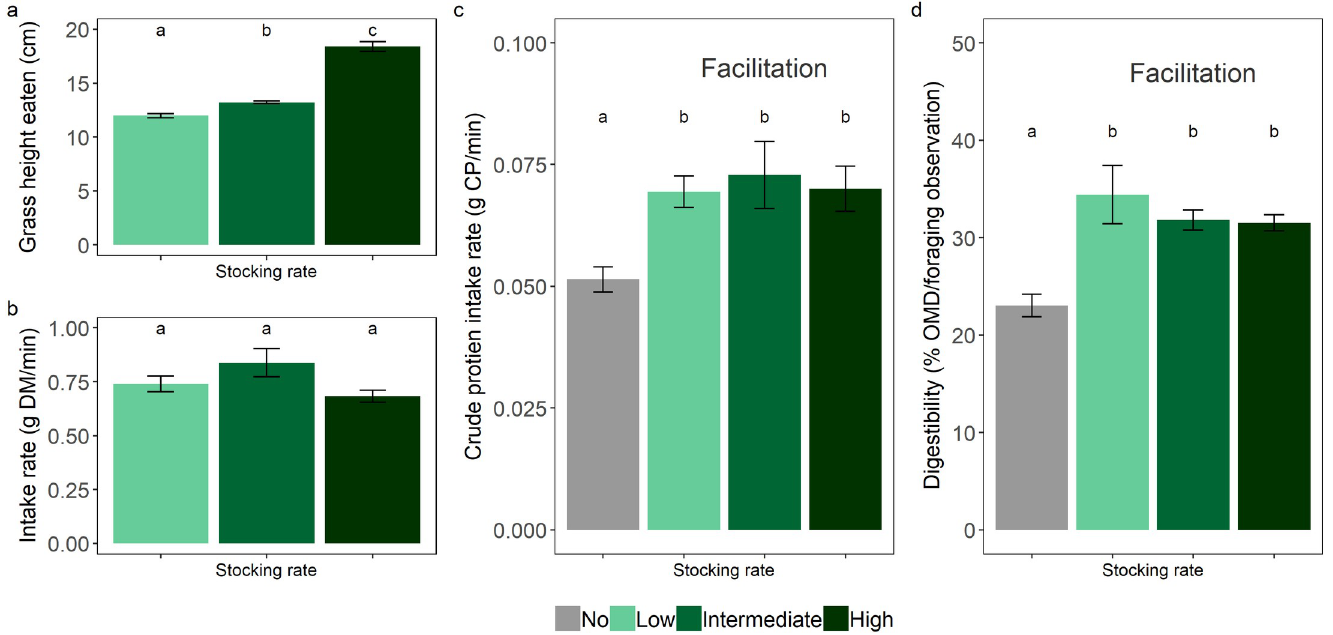
Fig 3. Wet season oribi antelope foraging metrics. Average (mean ± SE) for a) sward height eaten, b) intake rate, c) crude protein intake rate, and d) digestibility of consumed vegetation per foraging observation of oribi at low (1.7 ha per AU), intermediate (1.5 ha per AU) and high cattle stocking rates (0.95 ha per AU) during the wet season. The ‘No’ stocking rate in panels c and d are the crude protein intake rates that oribi obtained feeding in a camp without cattle. The difference in crude protein intake rates and the digestibility of consumed vegetation by oribi between when cattle are present or absent is the degree to which cattle facilitate oribi feeding. Letters denote significant